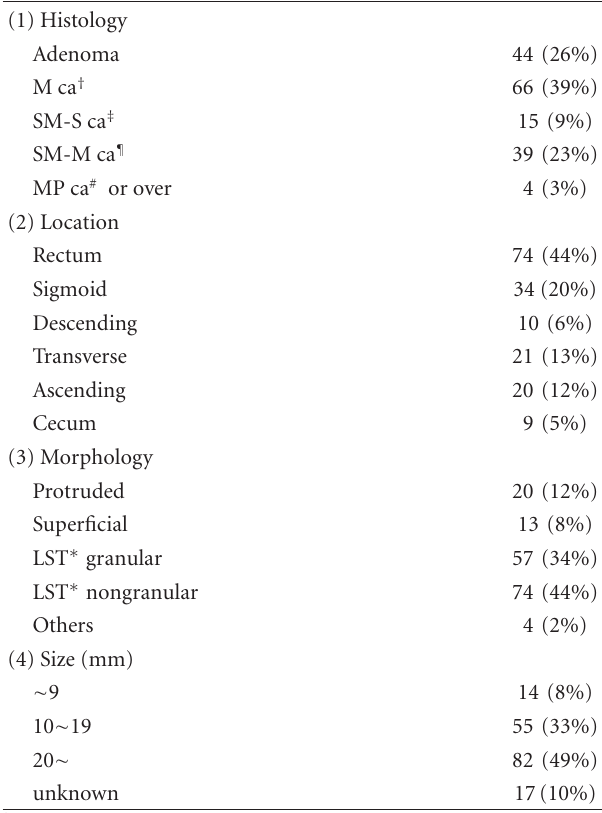
Table 1: Clinical characteristics of the study